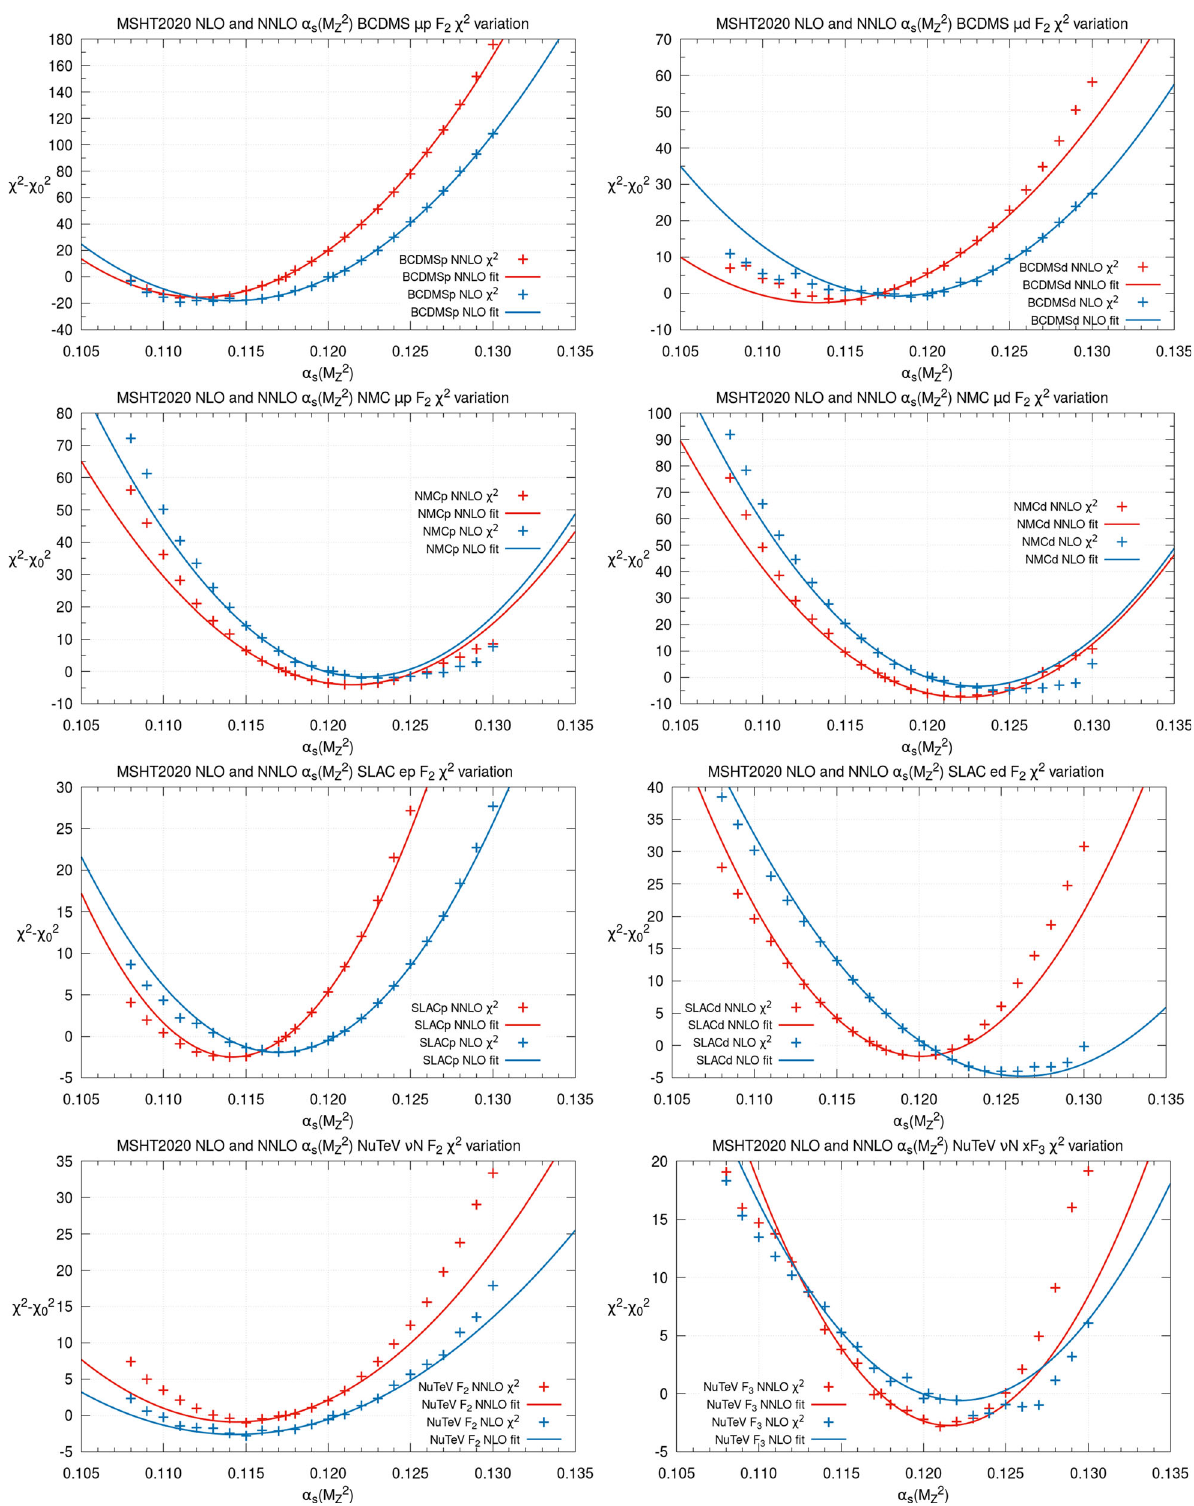
) values, whilst the curves Z